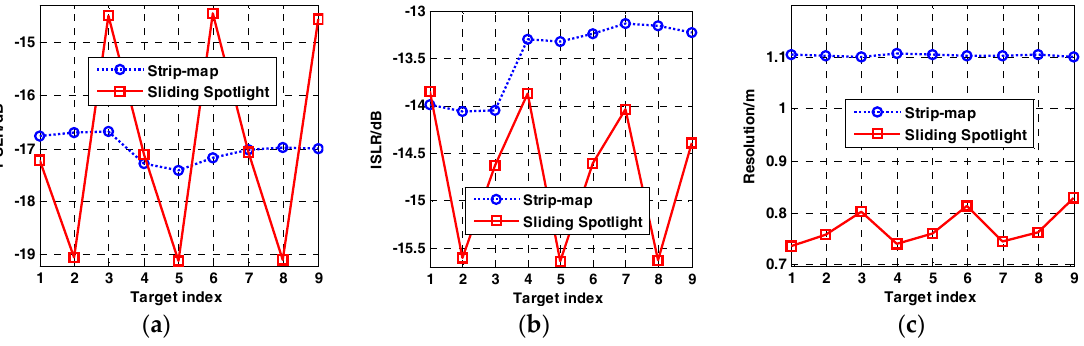
Figure 17. Distribution of focusing performances for SAR data with burst ‐ like perturbations. ( a – c ) are the distributions of PSLR, ISLR, and resolution, respectively. The blue dashed line and red one are the results of strip ‐ map and sliding spotlight, respectively.